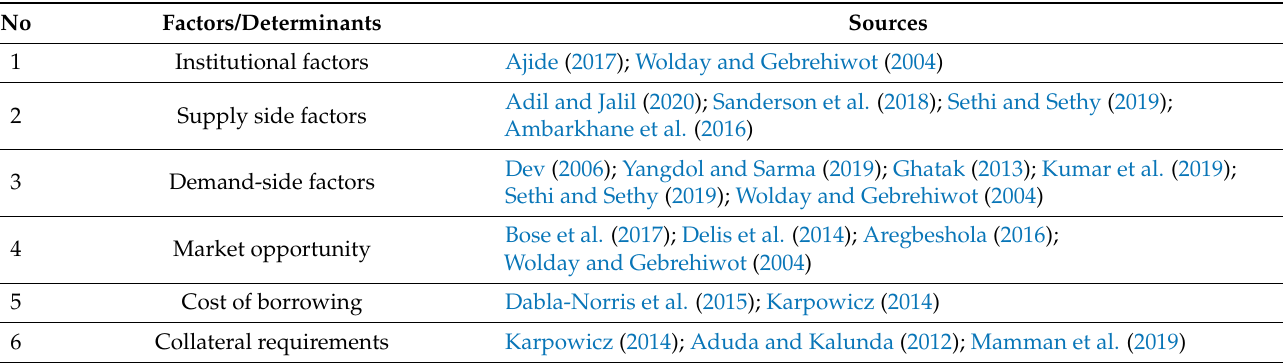
Table 2. Determinants of financial